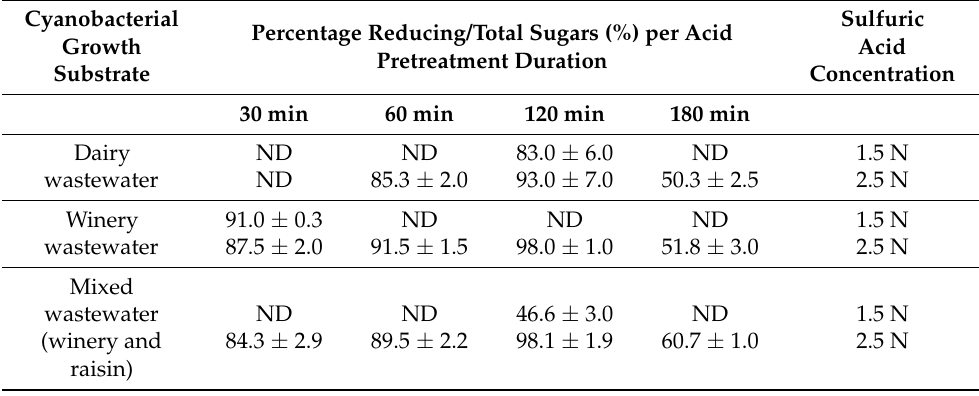
Table 3. Sugar yields obtained from acid pretreatment of biomass harvested from cyanobacterial cultures grown on different wastewater substrates (ND: not